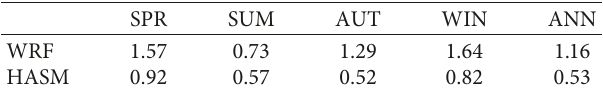
Table 3: Spatial correlation coefficient (SCC) values of the WRF model and HASM.